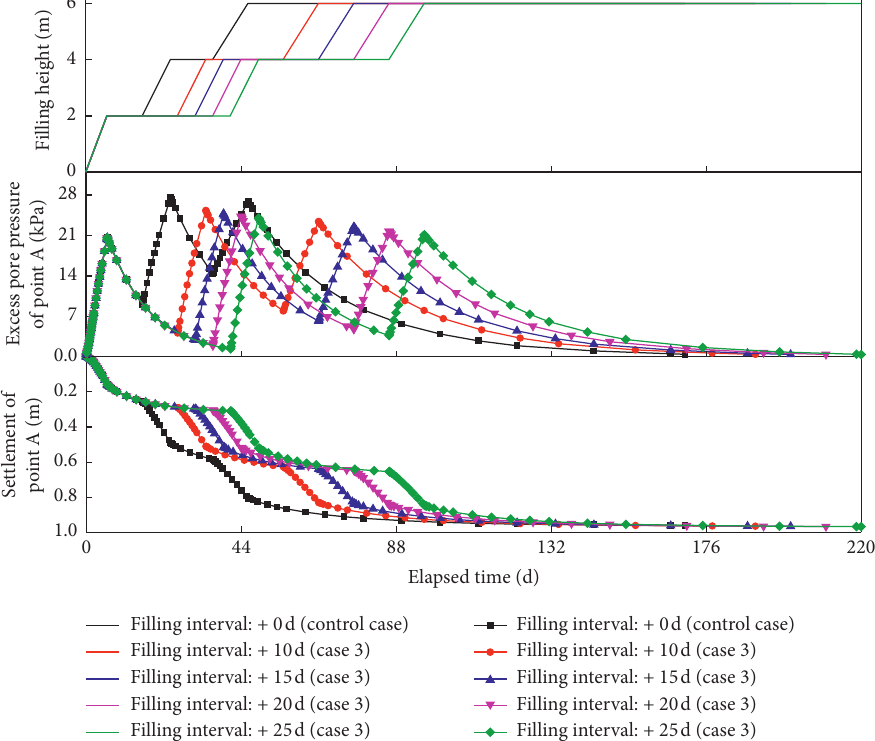
Figure 10: Influence of filling interval on excess pore water pressure and settlement of point A.